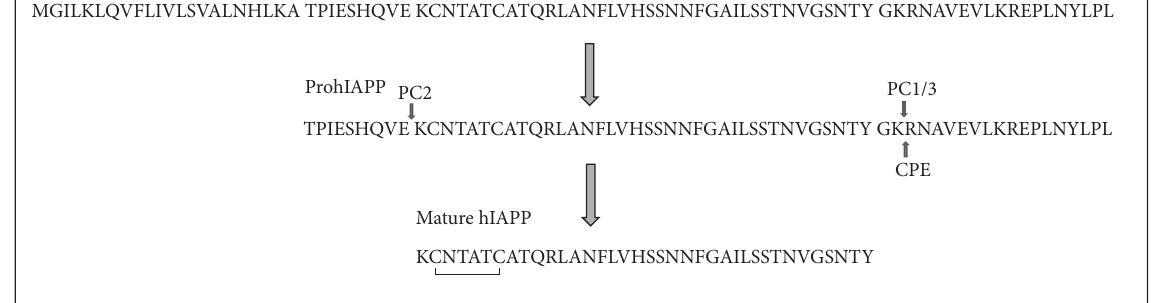
Figure 1: Processing of human PreproIAPP that lead to the formation of mature hIAPP. The cleavage site for PC2 and PC1/3 is indicated by arrows. The residues KR, indicated by arrow, which remain after the cleavage is induced by PC1/3 are removed by the carboxypeptidase E. This results in the amidation of the C-terminus of mature hIAPP. The disulfide bridge is shown on the mature